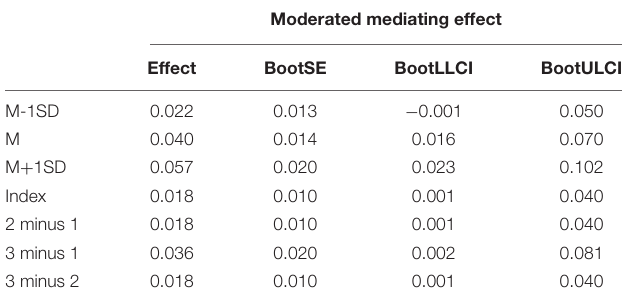
TABLE 10 | Moderated mediating effect of perpetrator sensitivity.